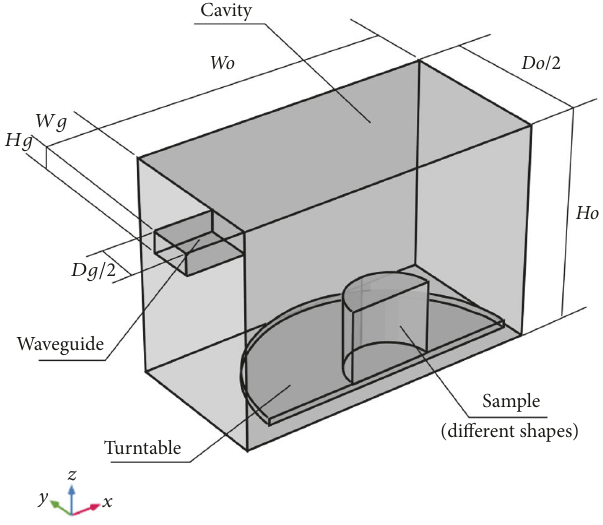
Figure 1: Schematic diagram of physical